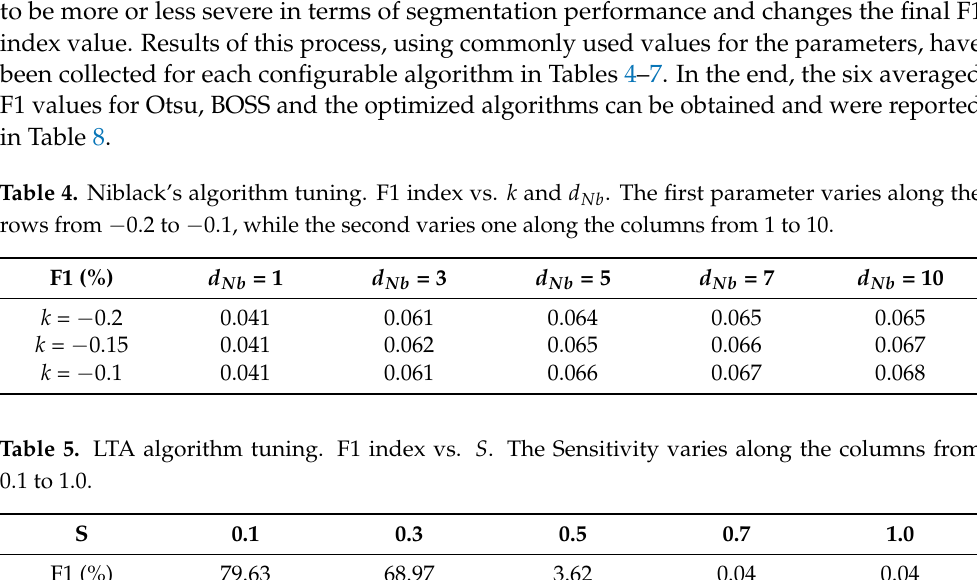
Table 6. WIT algorithm tuning. F1 index vs. δ . Here, δ varies along the columns from